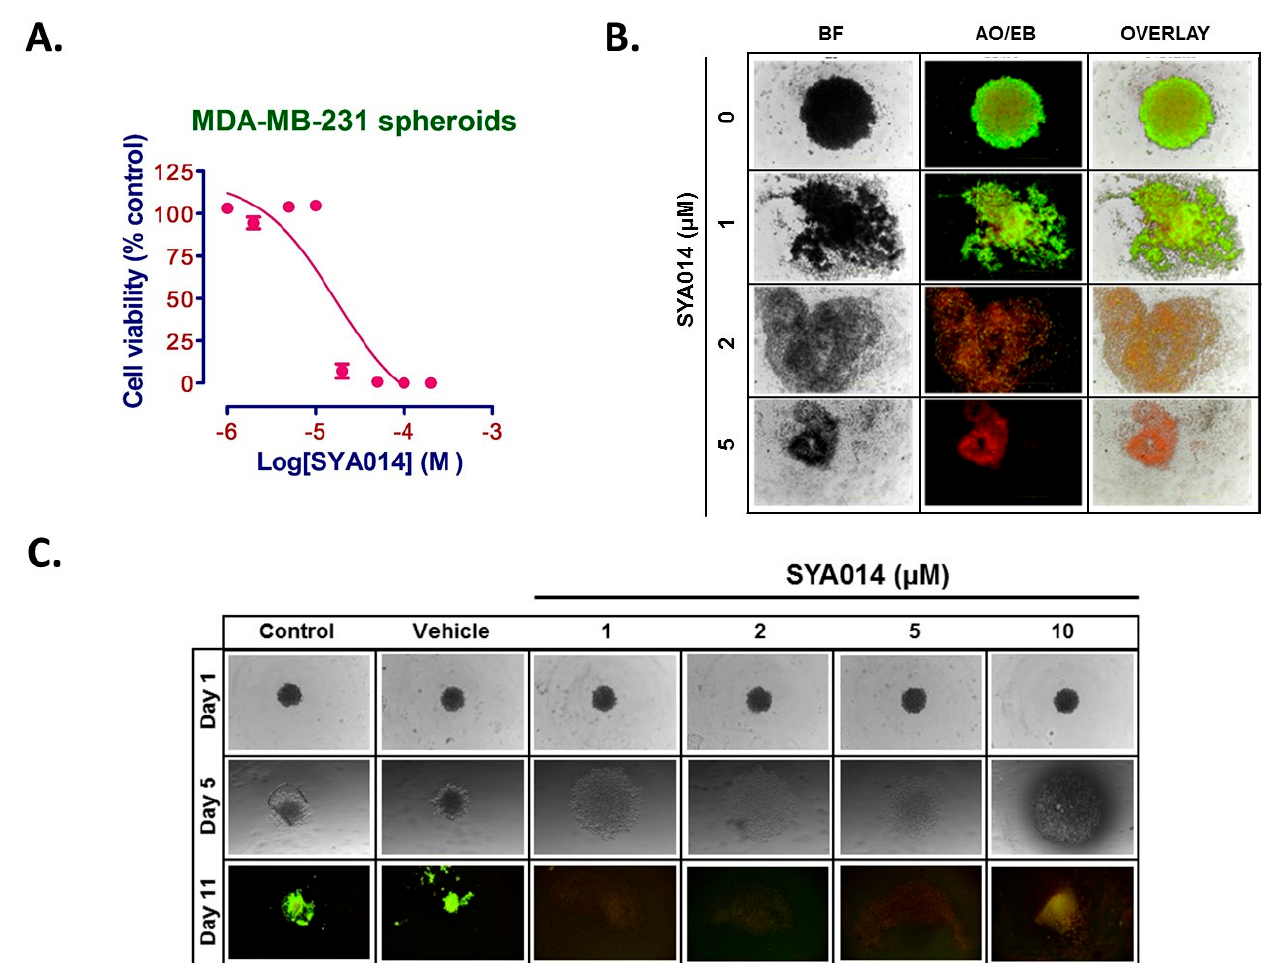
Figure 3. Effect of SYA014 on spheroids of MDA-MB-231 cells. Cell viabilities of MDA-MB-231 spheroids treated with SYA014 ( A ). MDA-MB-231 cells were seeded in 96-Well, U-shaped-bottom Nunclon Sphera plates and incubated for 24 h to form spheroids followed by treatment with SYA014 (0–200 µM) for 24 h and a second treatment for another 24 h (48 h treatment period). The cell viabilities were determined using resazurin reduction assay as described in the materials and methods Section 2.3. Each data point represents the mean ± SEM of 8 wells. SYA014 induces the disintegration of pre-formed spheroids ( B ) and prevents MDA-MB-231 spheroid formation ( C ) of MDA-MB-231 cells upon treatment with SYA014 for 48 h. For the disintegration of pre-formed spheroids, following the SYA014 treatment, spheroids of MDA-MB-231 cells were stained with acridine orange/ethidium bromide (AO/EB). For the inhibition of spheroid formation, on the 11th day, cells were stained with acridine orange/ethidium bromide (AO/EB). Live cells show green color and dead cells in red color. Note: Control and vehicle for day 1, day 5 and day 11 were kept the same while conducting the experiments for SYA014 and our previously published work involving SYA013 [15]. The images for control and vehicle groups are published and are re-used here. BF: Brightfield.